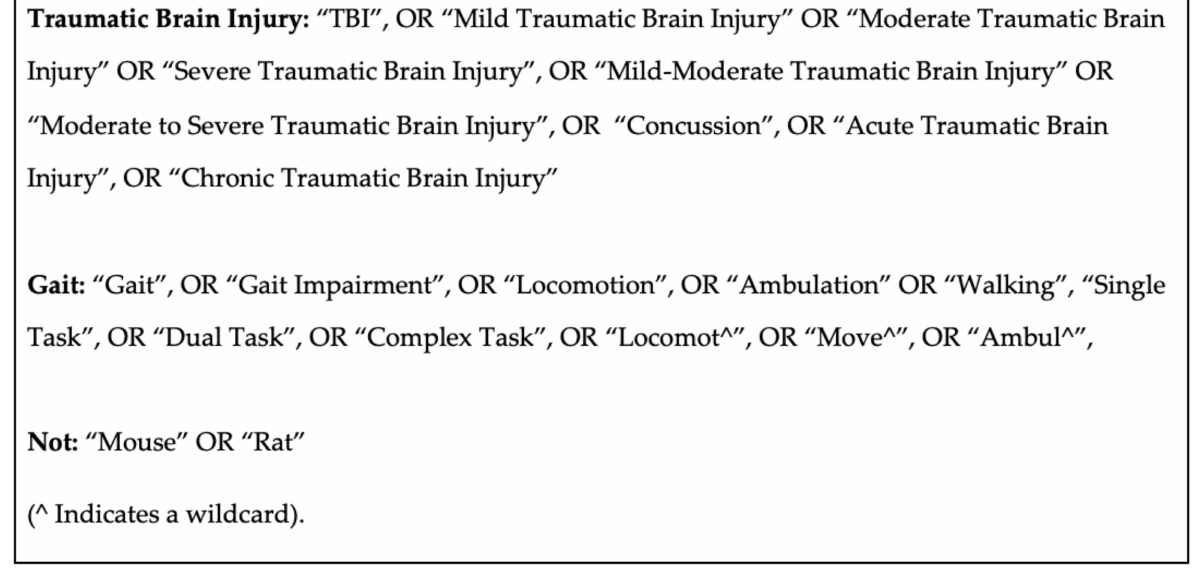
Figure 1. Key Search Terms. Reference to Title, Abstract and Key